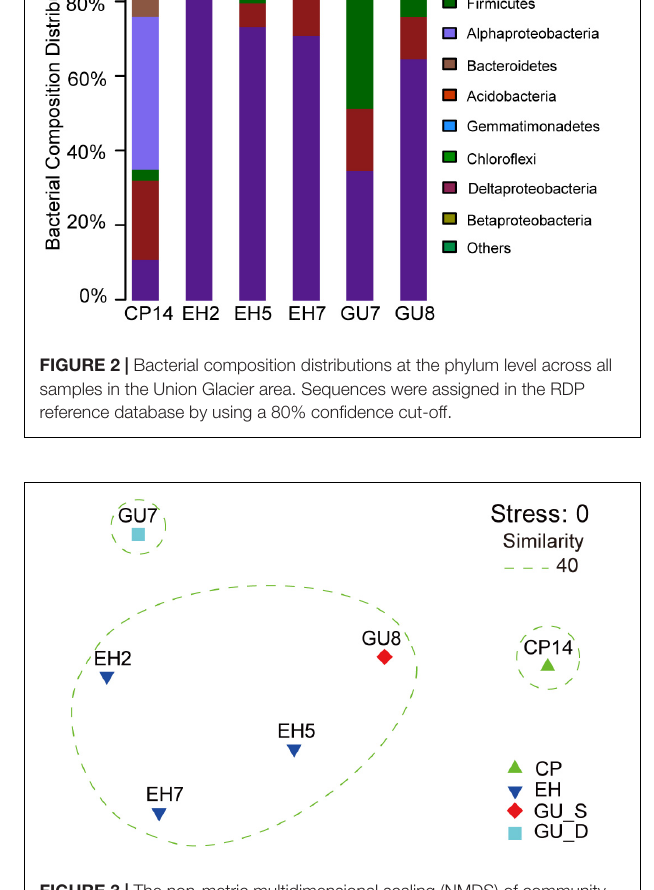
( Figure 3 ). The six samples divided into four